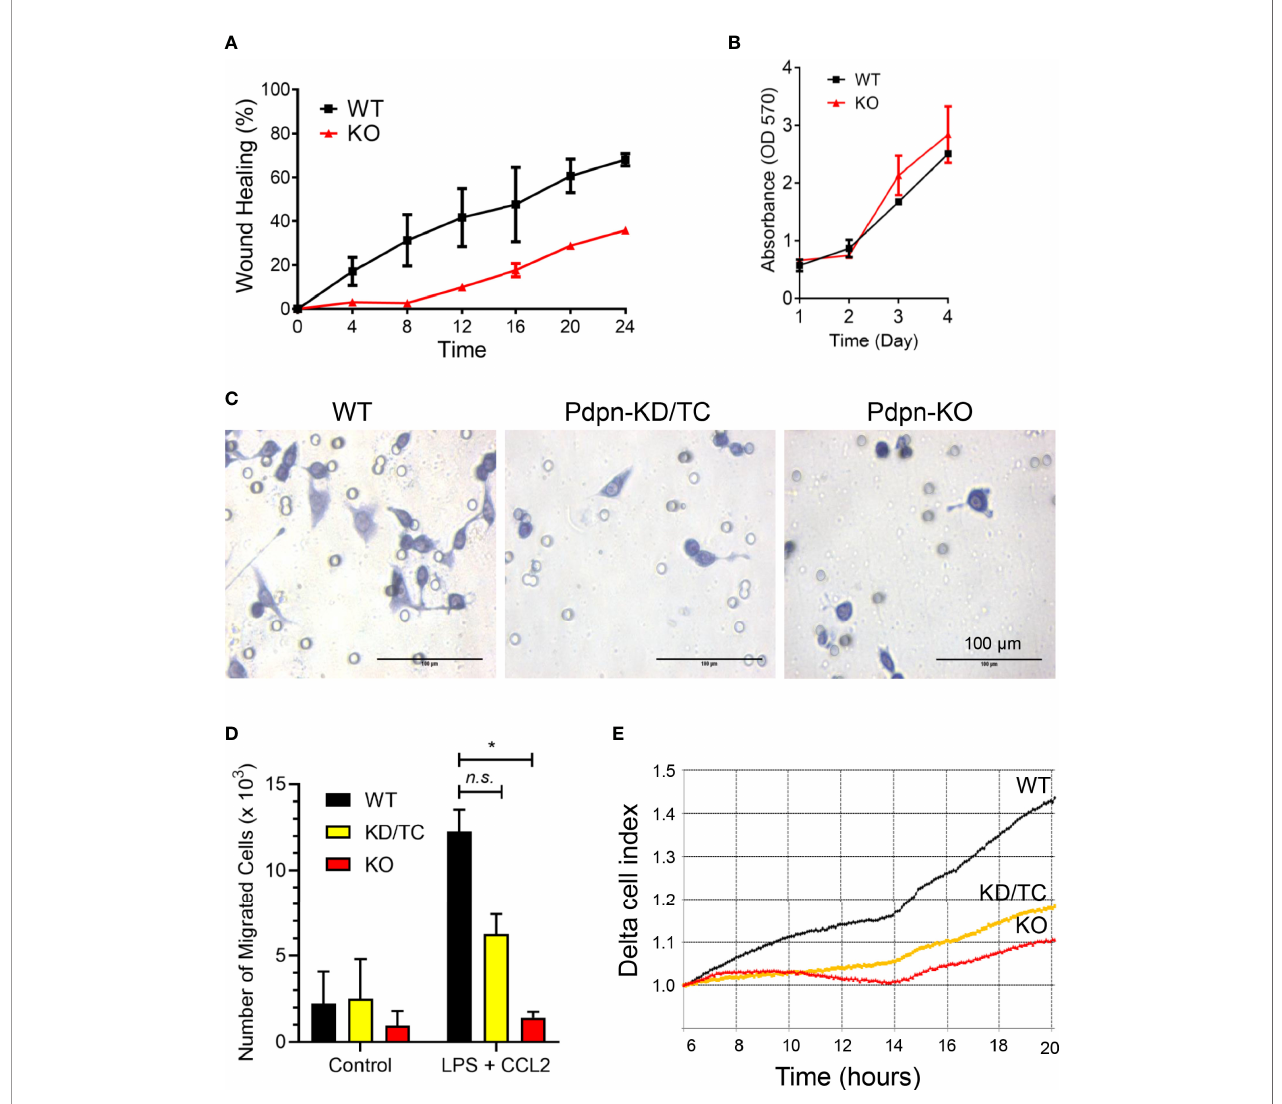
FIGURE 2 | Impaired motility of LPS-stimulated macrophages following Pdpn -deletion. (A) Graph shows percentages of wound healing in WT and Pdpn -KO cells. Con fl uent cells were scratched and viewed under NanoEntek JuLi BRD04 live cell imager for 24 h. Area of wound was measured every 4 h using ImageJ software. Note that Pdpn -KO demonstrated impaired wound healing ability as compared to WT cells. Data were presented as mean ± SD and were representative of three independent experiments. See Supplemental Video 1 . (B) Comparison of cell proliferation rate among the non-stimulated wild type (WT) and Pdpn -knockout (KO) stable clones using MTT assay. Similar number of cells were seeded and cultured over a period of 4 days. Cell growth was measured each day by adding MTT solution for 4 h, replaced with DMSO, before measuring on a plate reader. All samples were run in triplicate. Data are presented as mean ± SD from duplicate readings and are representative of two independent experiments. (C) Representative images of migrated cells for wild-type, Pdpn -KD/TC, and Pdpn -KO cells in transwell migration assay. Cells seeded at upper chamber of 8- m m transwell insert were induced with 20% FBS, 100 ng/ml CCL2, and 1 µg/ml LPS from the lower chamber and processed with crystal violet staining after 24 h. Circles indicate the pores in the transwell. Scale bars indicate 100 m m. (D) Histogram shows number of migrated cells in transwell migration assay. Data were shown as mean ± SD from duplicates and were representative of three independent experiments. Statistical signi fi cance was analyzed with two-way ANOVA test ( F value: 5.77; degree of freedom: 6; *p < 0.05; n.s ., not signi fi cant). (E) Real-time migration rate of wild-type, Pdpn -KD/TC, and Pdpn -KO cells in RTCA analysis. Cells seeded at the upper chamber of CIM-16 plate were induced with 20% FBS, 100 ng/ml CCL2, and 1 µg/ml LPS, from the lower chamber. Data were normalized at the sixth hour time point and are representative of two independent